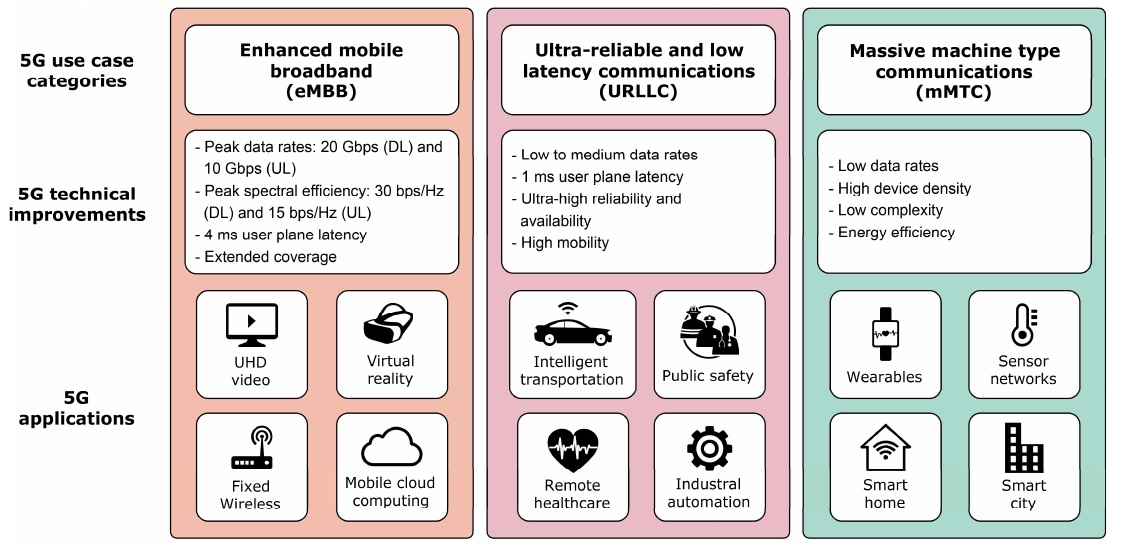
Figure 1. Three main use cases of 5G mobile networks.